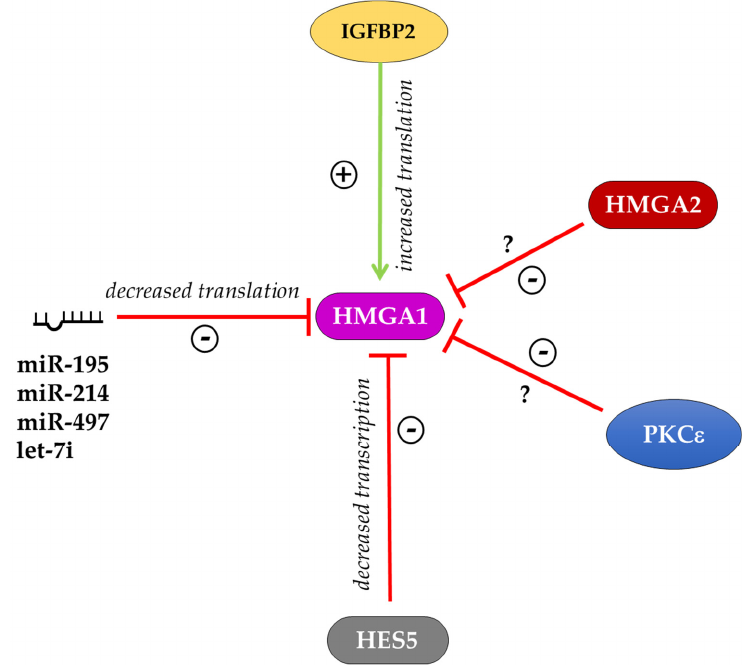
Figure 2. Schematic representation of HMGA1 expression regulation. HMGA1 is positively regulated by IGFBP2 at the post-transcriptional level. The transcriptional repressor HES5 and several miRNAs downregulate the expression of HMGA1. The kinase PKC ε and HMGA2 repress HMGA1 expression through mechanisms that are still unknown. The sign + indicates improved expression of the target, the sign – indicates impaired expression of the target.